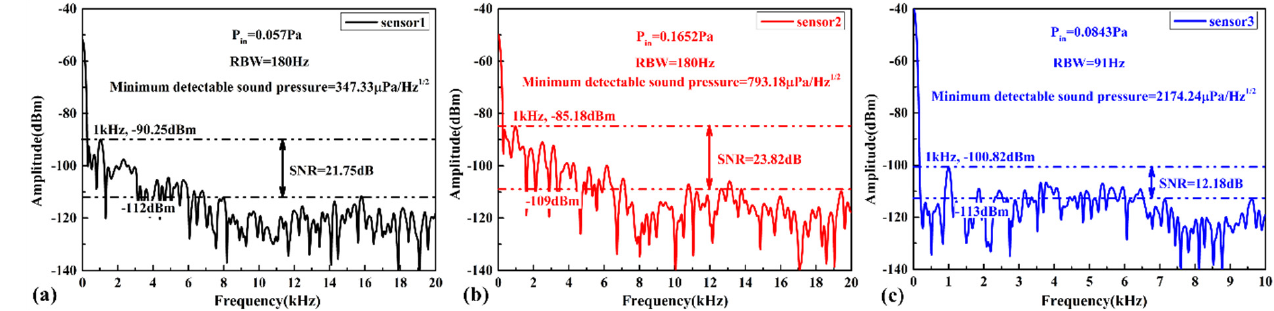
Figure 12. Response spectrograms of ( a ) sensor 1, ( b ) sensor 2 and ( c ) sensor 3 at 1 kHz acoustic signal when the maximum sensitivity is obtained.